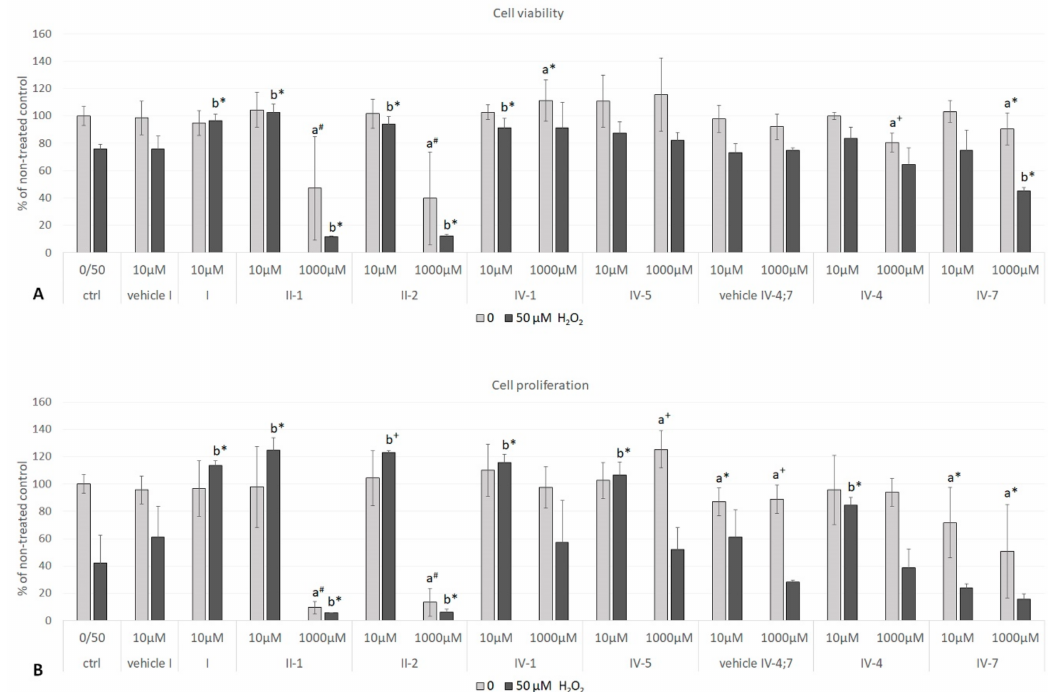
Figure 3. Cell viability ( A ) and proliferation ( B ) upon 24-h treatment with DHPs followed by 1-h exposure to H 2 O 2 . Results are expressed as a percentage of non-treated control. Statistically significant differences between—(a) DHPs alone vs. non-treated control (pale grey bars) or (b) DHPs treated vs. treated control (dark grey bars) are shown as follows: a*/b* p < 0.05; a + /b + p < 0.005; a # /b # p < 0.0005. Values are given as mean ± standard deviation, n =